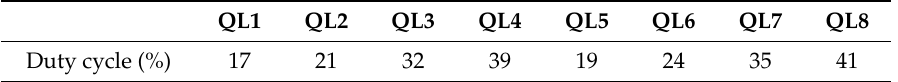
Figure 20. Output powers under the change of temperature. Table 7. Optimal duty cycle in eight control zones.